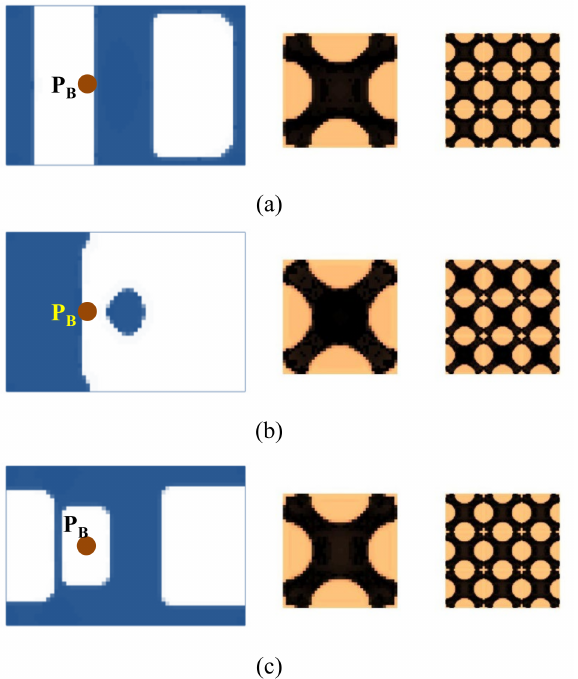
Figure 22. Design results obtained by varying the excitation frequency at excitation position P B . ( a